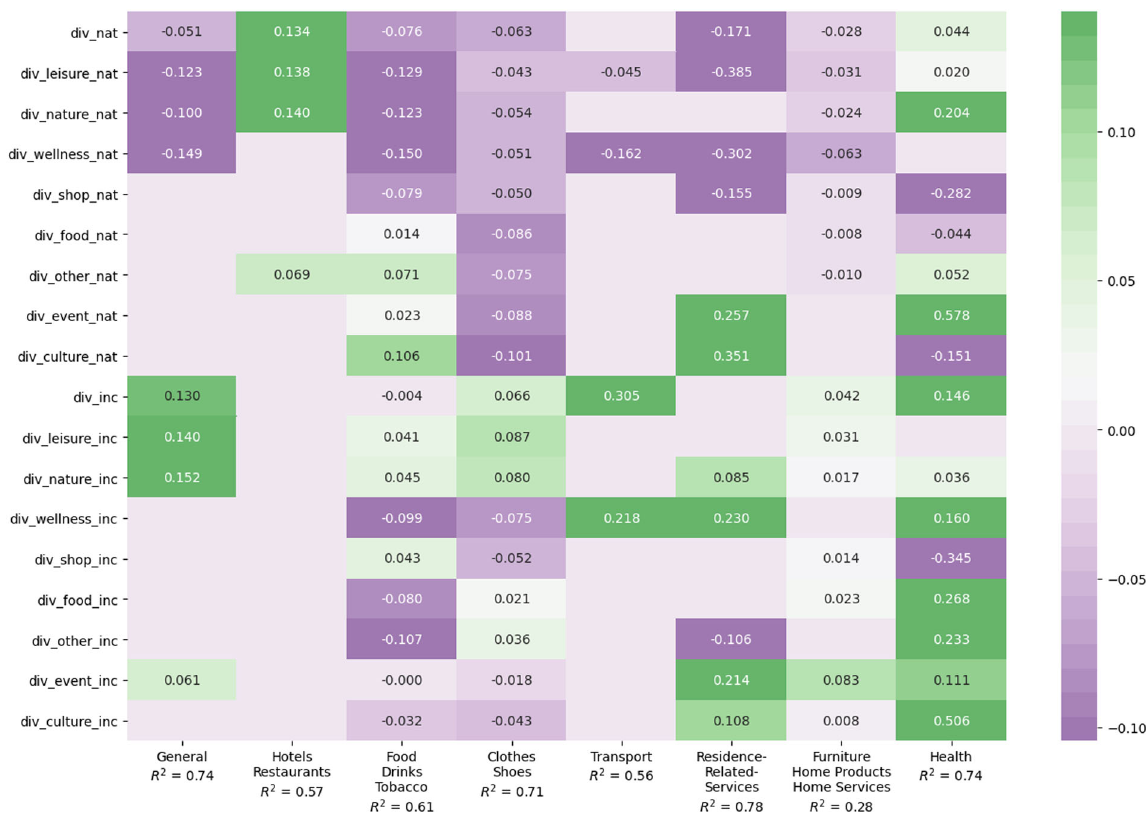
Fig. 5 Covariate selected by elastic net regression. We present the coef fi cients selected via elastic net regression. The value in the cell correspond to the coef fi cients in the selected model. The covariates with non-zero coef fi cients are presented.